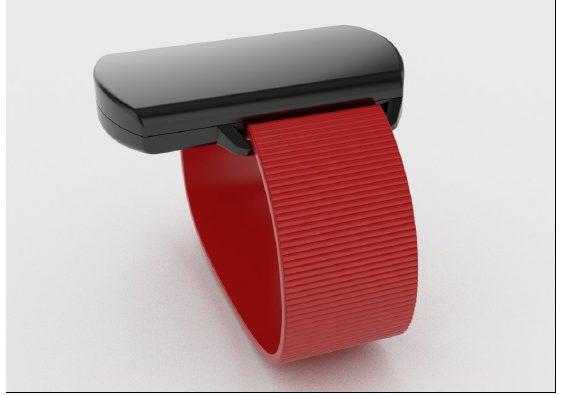
Figure 6. The enclosure of